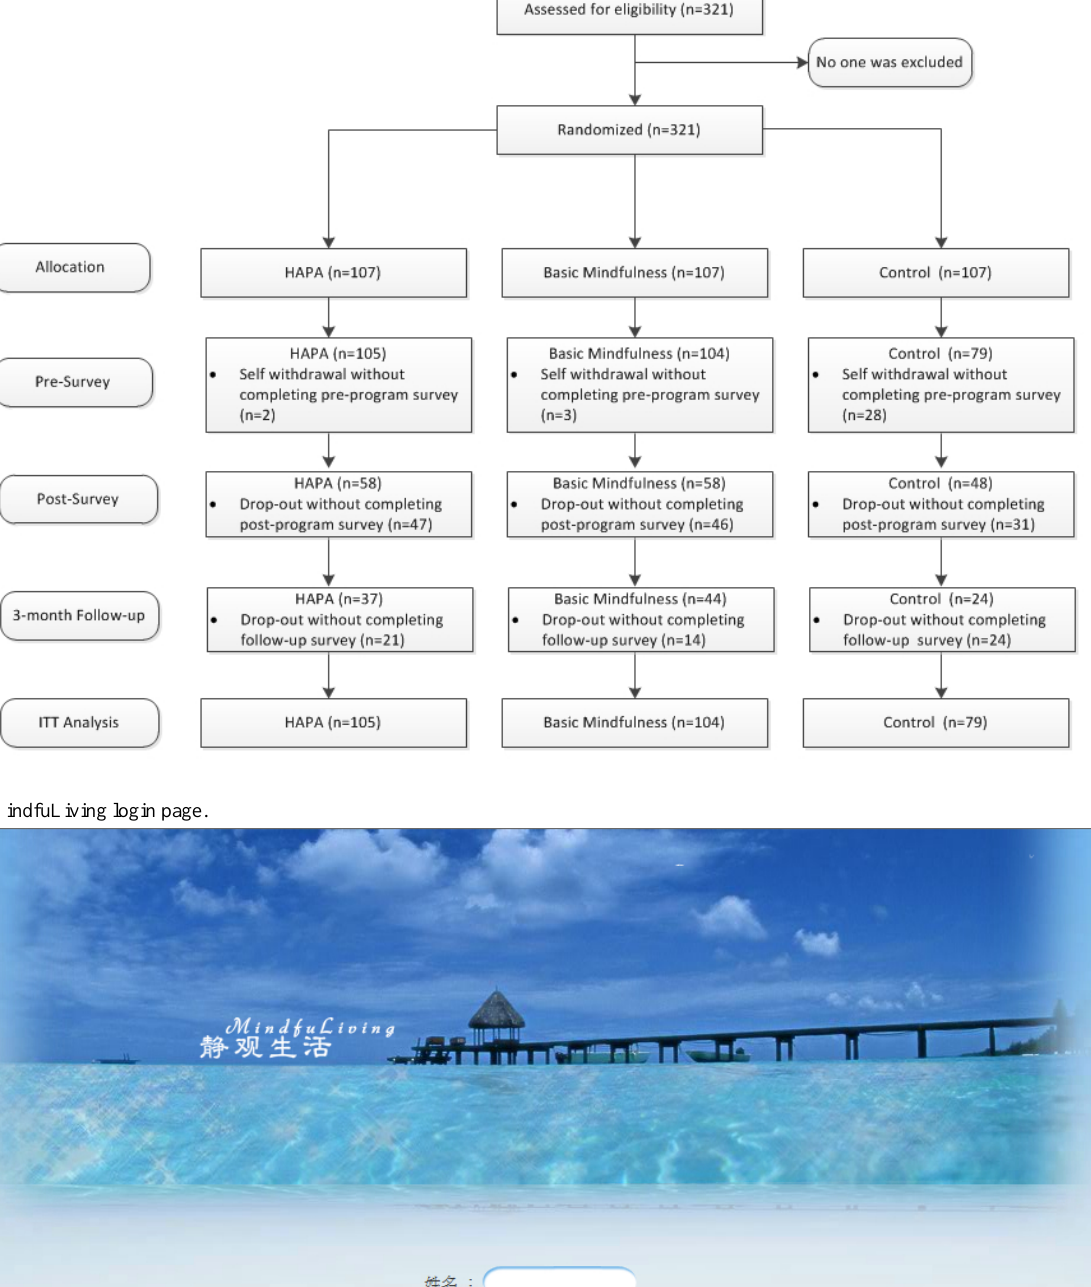
Figure 1. Flowchart of randomization and retention of participants.